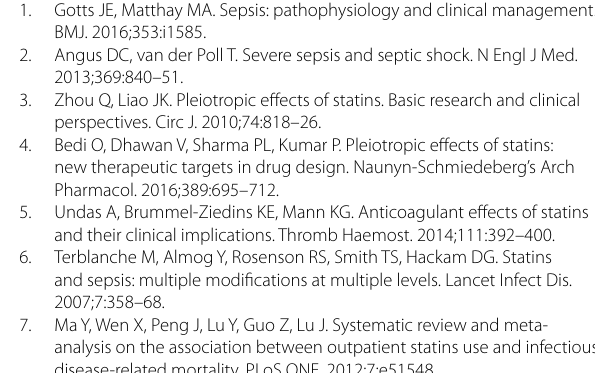
Additional file 1: Figure 1. Flowchart of patients. Figure 2. Distribution of propensity scores. Figure 3. Blood transcriptomics of sepsis patients discordant for statin therapy. Table 1. Host response biomarkers in sepsis patients admitted to the ICU stratified according to prior use of statins